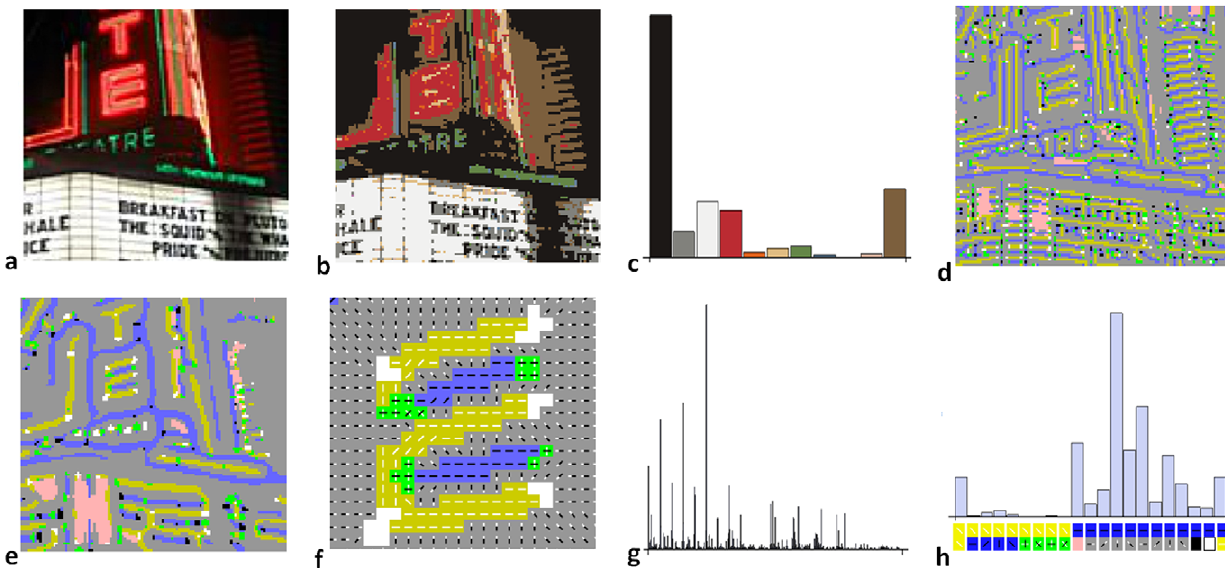
Figure 4. Image encodings used. ( a ) an example image for the category cinema , ( b ) each pixel is classified as one of the eleven Basic Colours, ( c ) the histogram of these is the color-based image encoding; ( d,e ) each pixel is classified as one of the 23 oriented Basic Image Features (oBIFs) at a fine and a coarse scale ( f ) a detail from e (slightly north-west of centre) showing the orientations of the oBIFs, ( g ) the histogram of ordered pairs of fine and coarse scale oBIFs is the texton-based image encoding, ( h ) a zoomed detail from